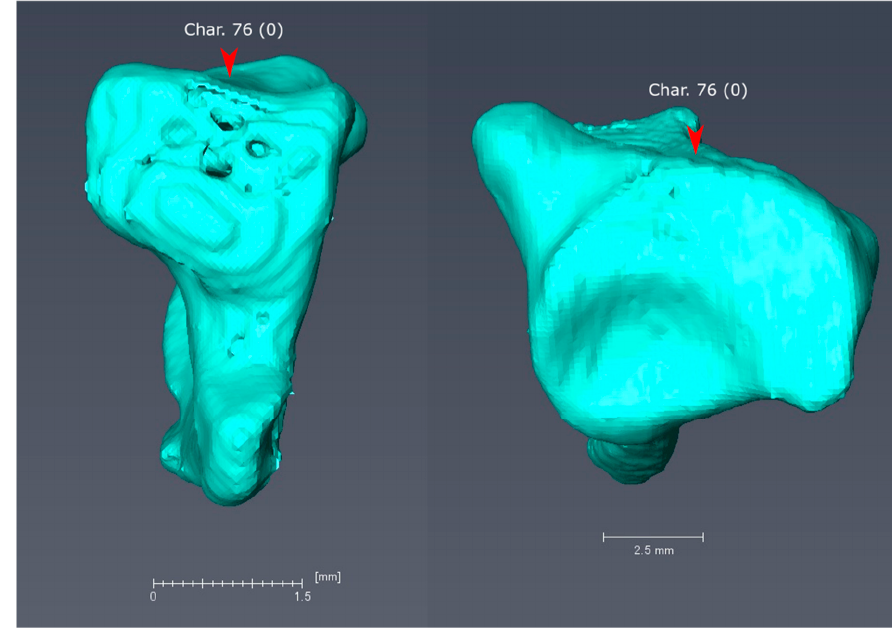
Figure A7. Manual phalanges II-1 of Aegotheles cristatus (left) and Podargus strigoides (right) in distal view. Arrows indicate the cranial facies. Aegotheles exhibits state 0 for character 76 (cranial face of manual phalanx II-1 narrow), whereas Podargus exhibits state 1 (cranial face of manual phalanx II-1 widened, optimized as a synapomorphy of Podargiformes).